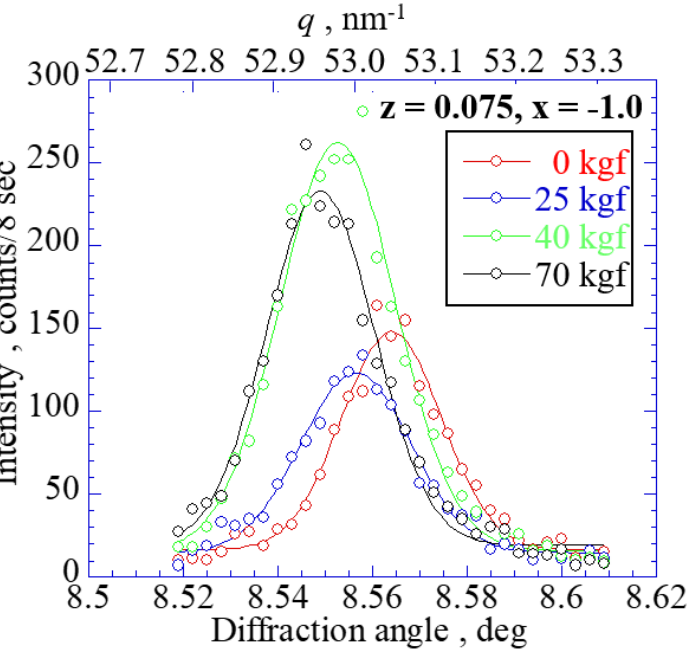
Figure 4. Diffraction profiles of α - Fe211 under a high temperature and tensile load.